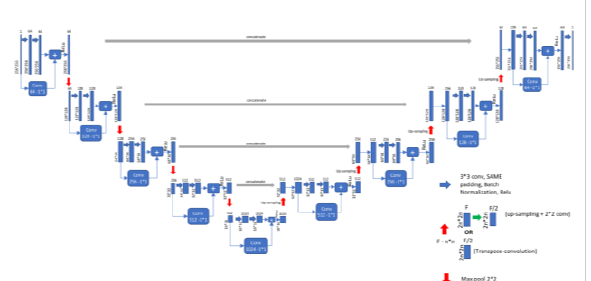
Figure 7 . U-Net standard